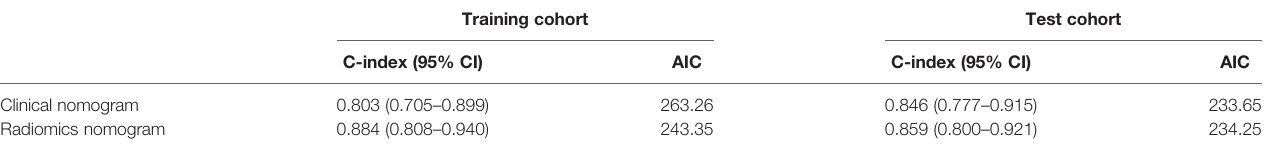
TABLE 3 | Performance of the